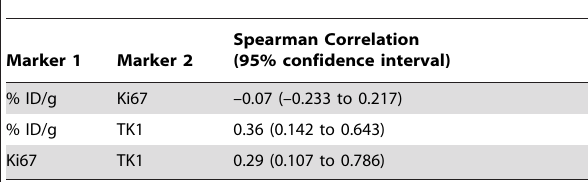
Table 3. Summary of Spearman correlation statistics between [ 18 F]-FLT uptake and IHC proliferation markers including 95 th percentile confidence intervals from bootstrap